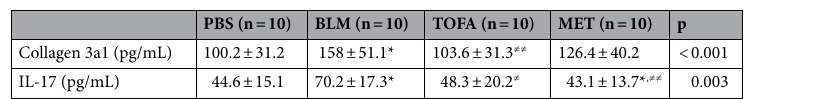
Table 2. Mean gene expression of collagen 3A1, IL-17 and TGF-β in skin tissue of study groups. BLM bleomycin, MET metformin, PBS phosphate-buffered saline, TOFA tofacitinib . Data were expressed as mean ± standard deviation. When compared with the PBS group: *p < 0.05, **p < 0.001. When compared with the BLM group: ≠ p < 0.05, ≠≠ p < 0.01, ≠≠≠ p < 0.001.